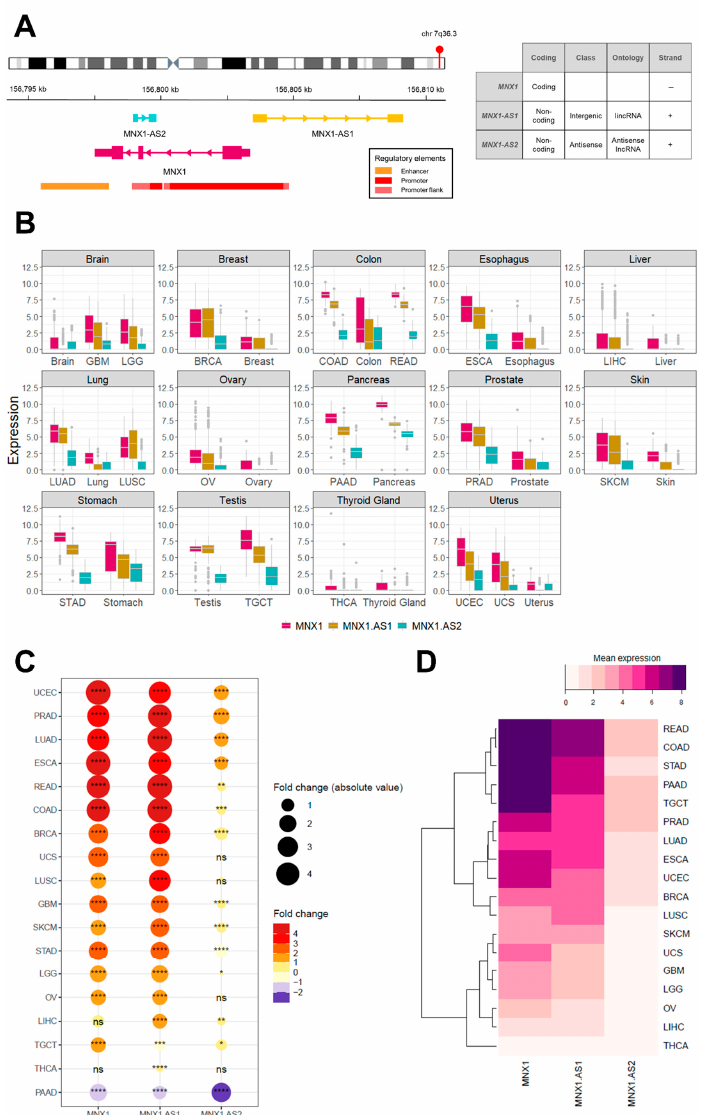
Figure 1. Overview of expression of MNX1 , MNX1 -AS1, and MNX1 - AS2 in cancers of the